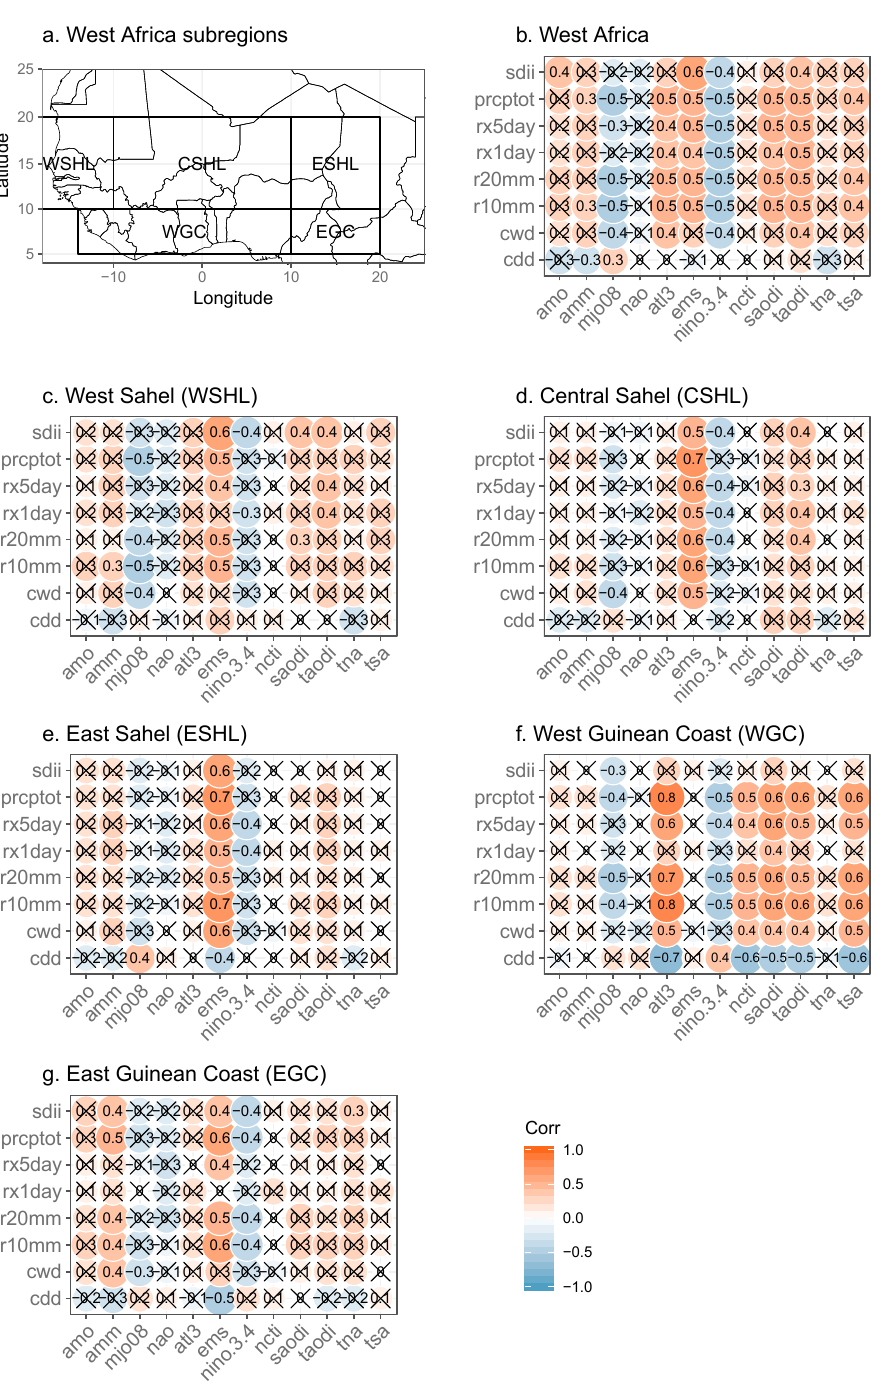
Figure 4. Correlation matrix between West Africa sub-regions extreme precipitation indices and remote climate indices. ( a ) West Africa subregions delimitation, ( b ) correlation between averaged extreme precipitation indices in West Africa and remote indices, ( c – g ) correlation between averaged extreme precipitation indices in subregions and remote